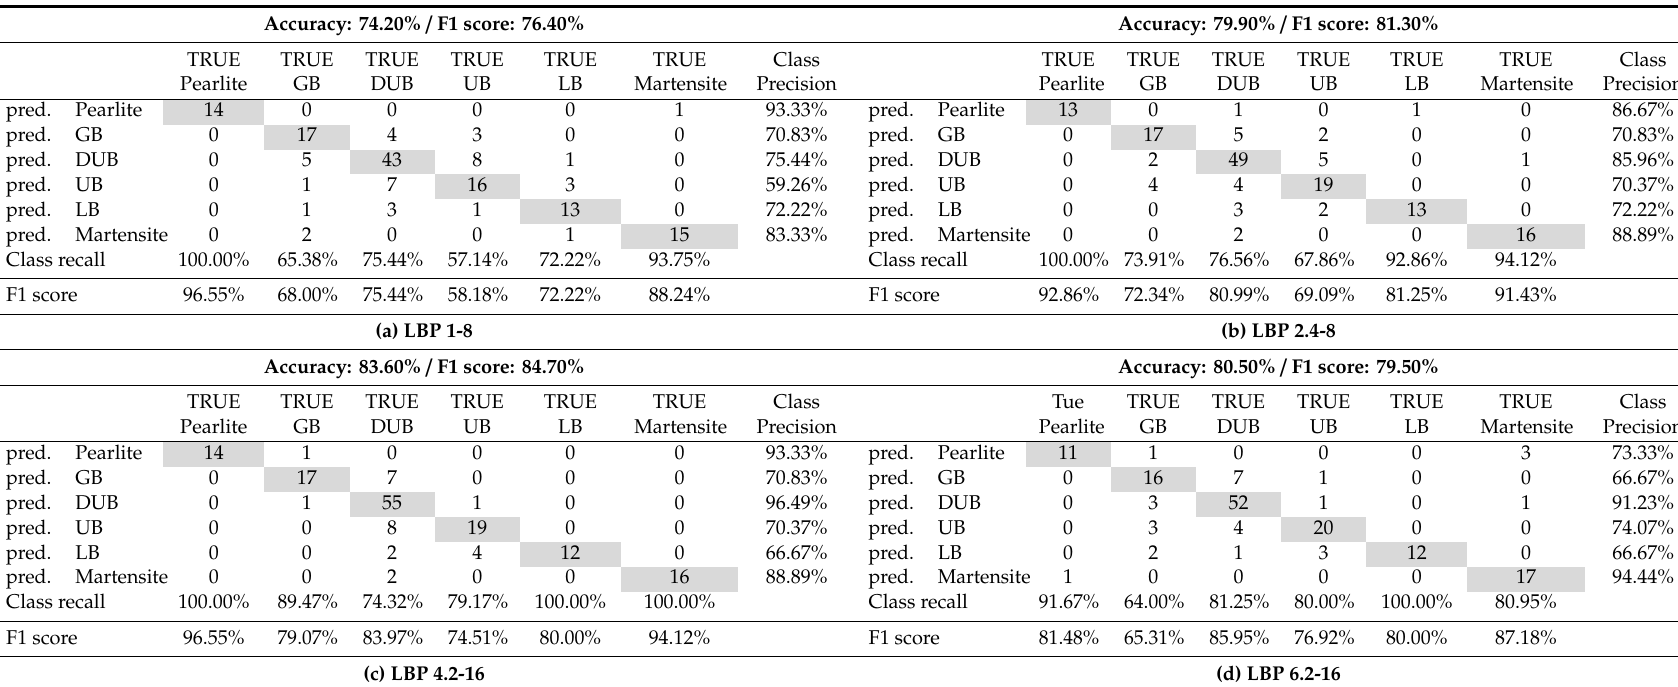
Table 4. Confusion matrices for the classification using single-scale local binary pattern: (a) radius R = 1, number of neighbors N = 8 (1 / 8), (b) 2.4 / 8, (c) 4.2 / 16, and (d) 6.2 /